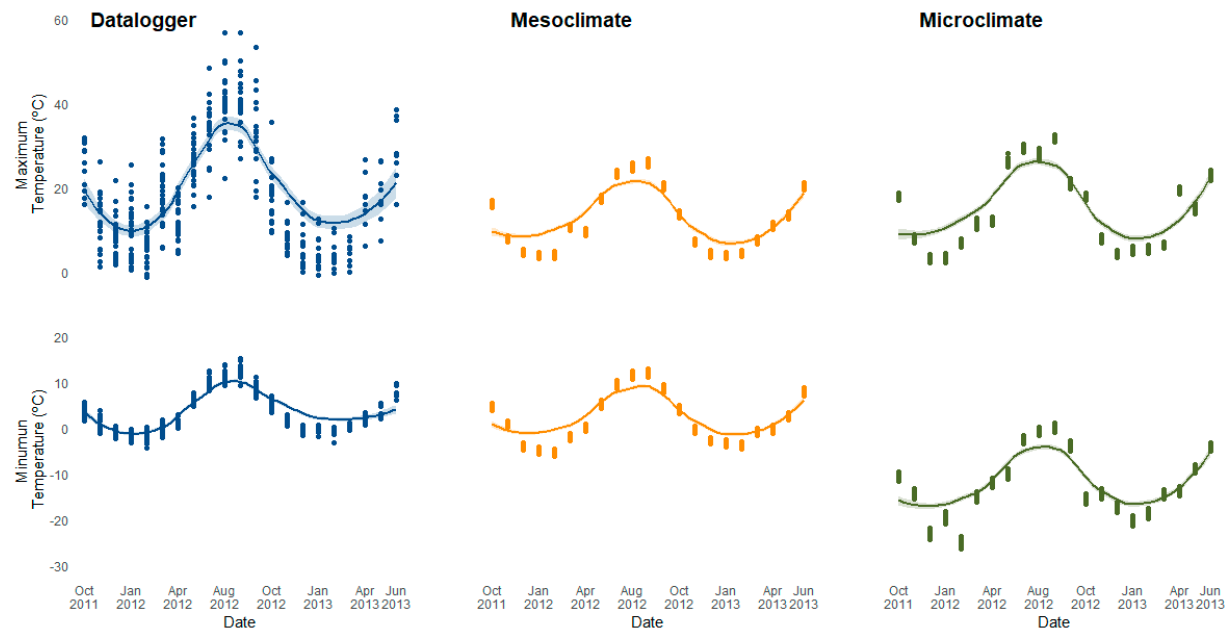
Figure 4. Field validation of monthly maximum (above) and minimum (below) temperatures ( ◦ C) in the Sierra de Guadarrama. Temperatures from October 2011 to June 2013 are shown for the 25 dataloggers (left column, blue points), associated 1 km resolution mesoclimate data (centre, orange) and 30 m resolution microclimate data (right, green). Lines show loess curves.